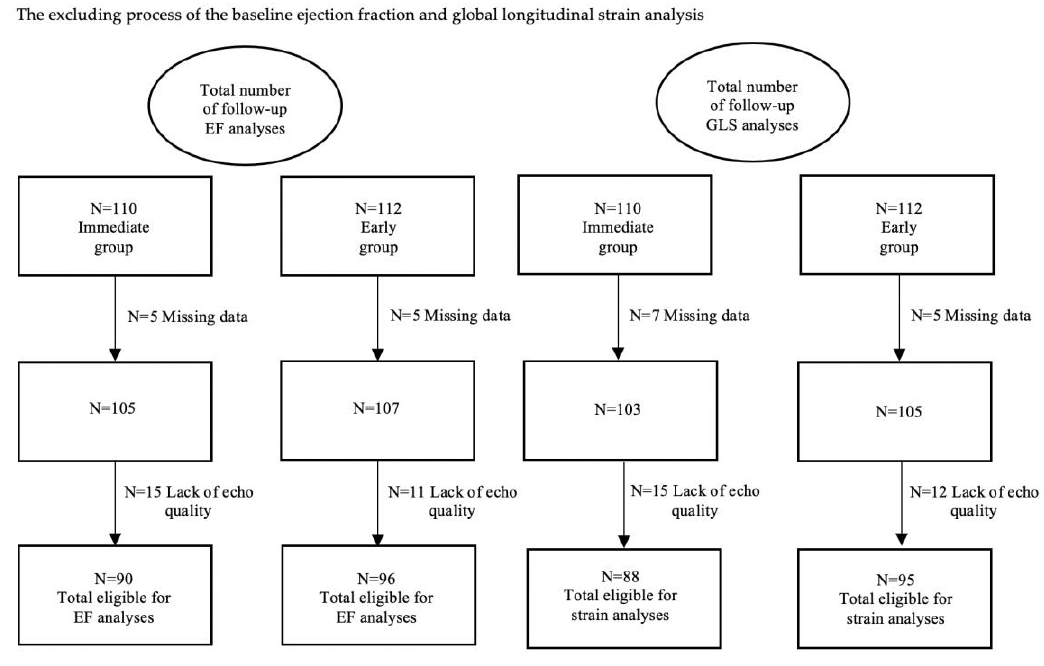
Figure 1. Study flow chart.